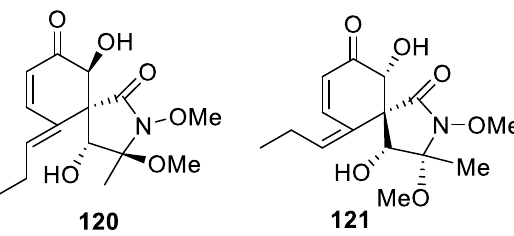
Figure 57. Structures of representative spirostaphylotrichins possessing a [4.5.0] spirocyclic motif.